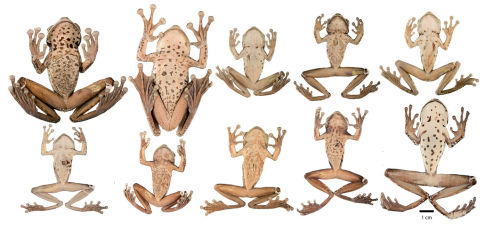
Ventral views of adult Osteocephalus festae showing variation in ventral coloration of preserved specimens. Specimen identity and arrangement is the same as in Figure 6.